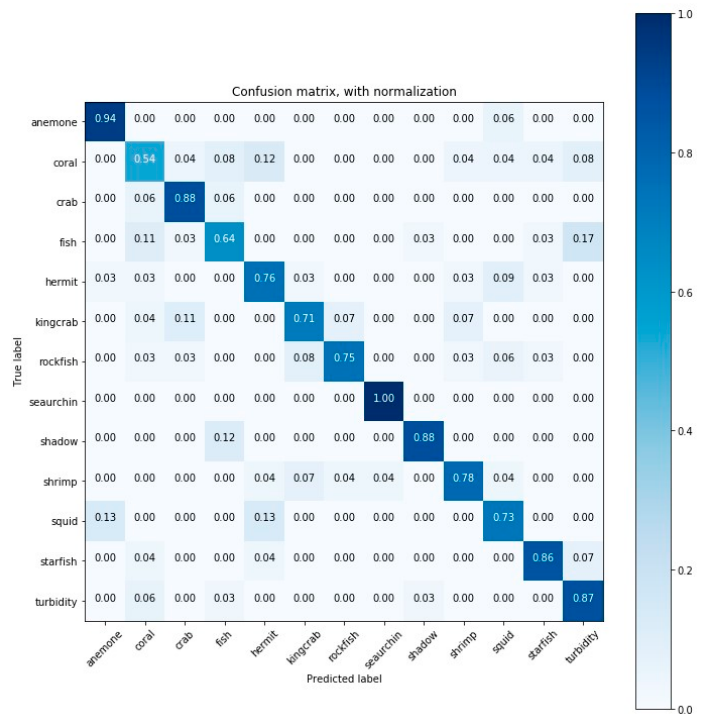
Figure A14. Confusion matrix for the classification results (accuracy) obtained by DNN-4.